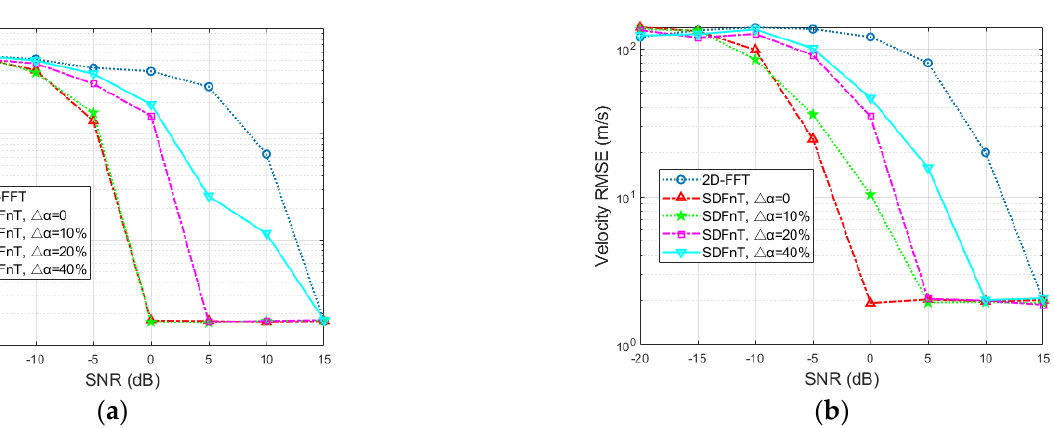
Figure 9. Scattered multi-target results in terms of SNR ( a ) RMSE for the range estimation ( b ) RMSE for the velocity estimation.